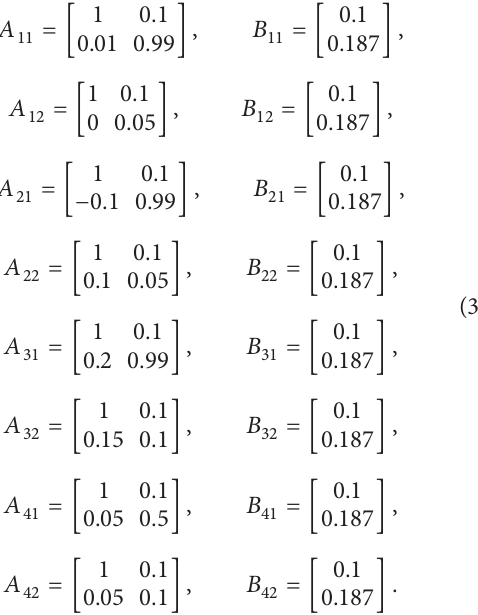
Algorithm 7 (simplified MPC applying polyhedral invariant